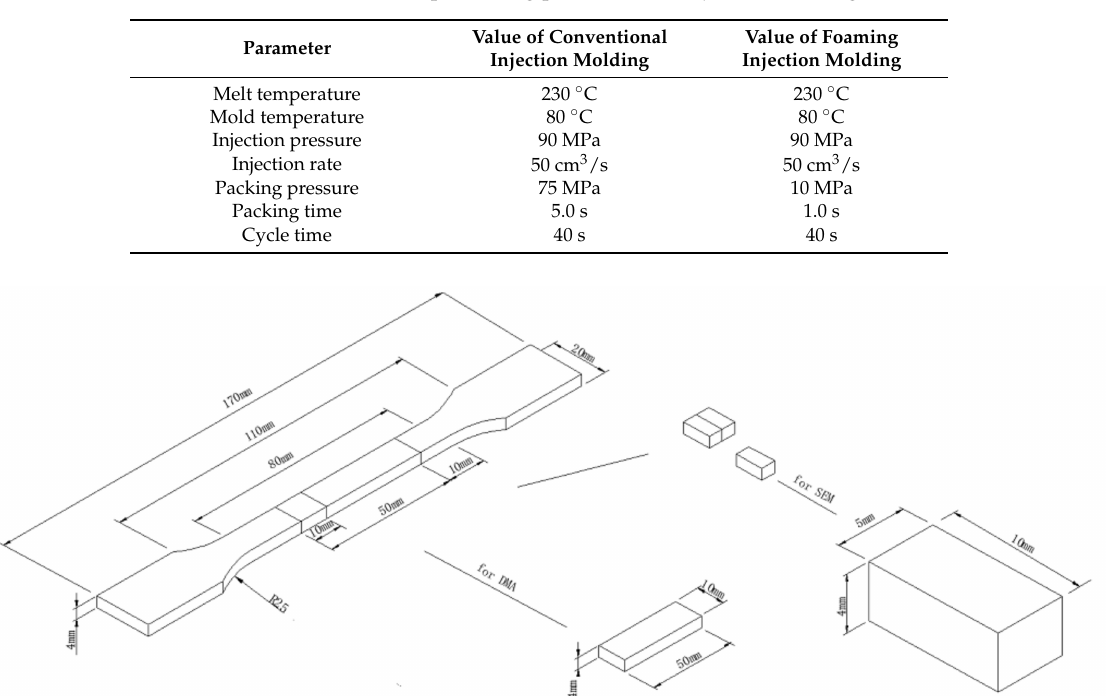
Table 2. The selective processing parameters of injection molding.